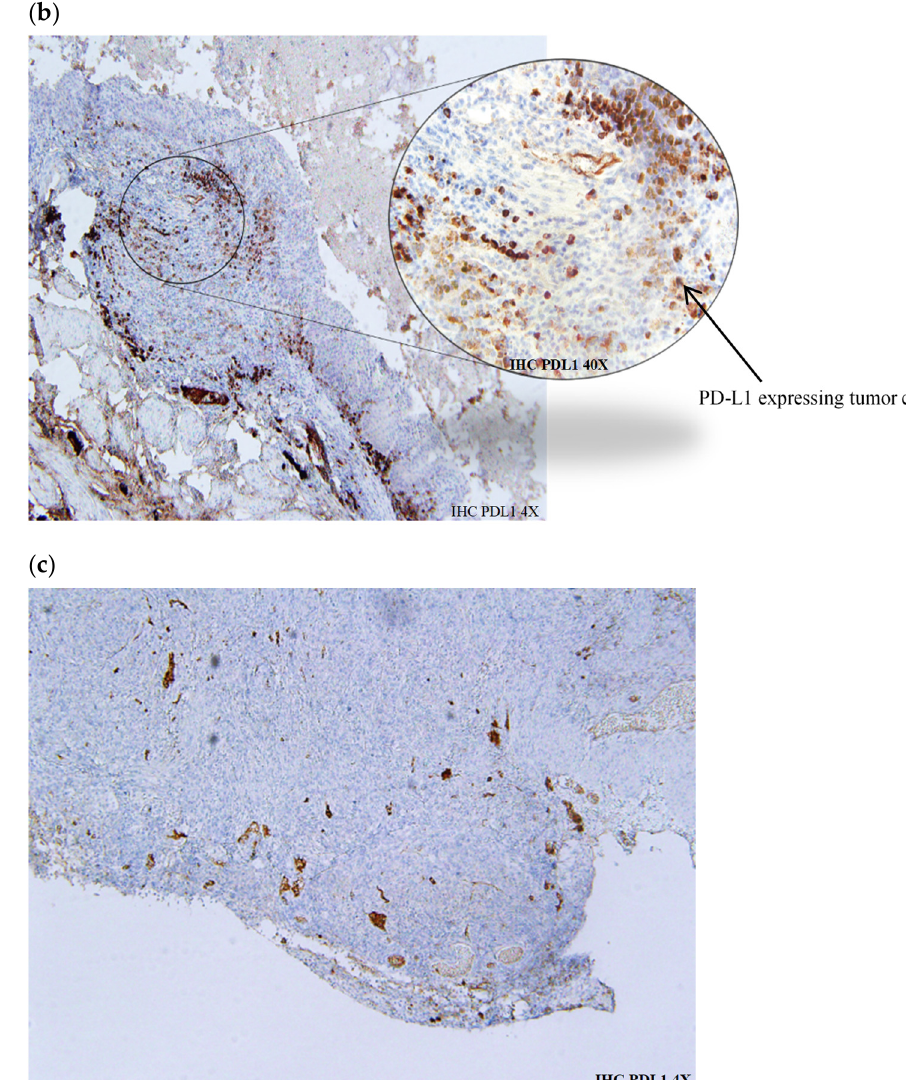
Figure 3. Representative images of PD-L1 staining. ( a ) Typical image of strong membranous PD-L1 expression (>50%). Example of bladder sample treated with HAL BL. Membranous PD-L1 expression in tumor cells (10 × ). Photo captured at 12 days post-grafting; ( b ) typical image of moderate membranous PD-L1 expression (1 < PD-L1 < 49%). Example of bladder sample treated with BL. Membranous PD-L1 expression in tumor cells ( × 4). Photo captured at 30 days post-grafting; ( c ) typical image of weak membranous PD-L1 expression (<1%). Example of bladder sample treated with HAL BL ( × 4). Photo captured at 30 days post-grafting.